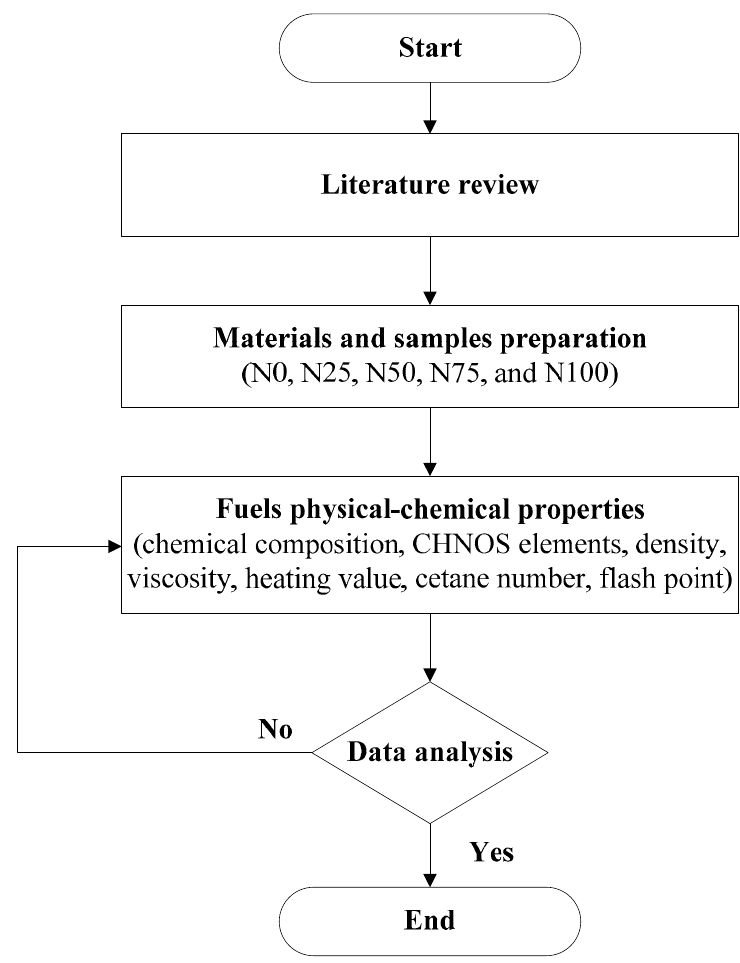
Figure 1. Schematic diagram of the research strategy framework.